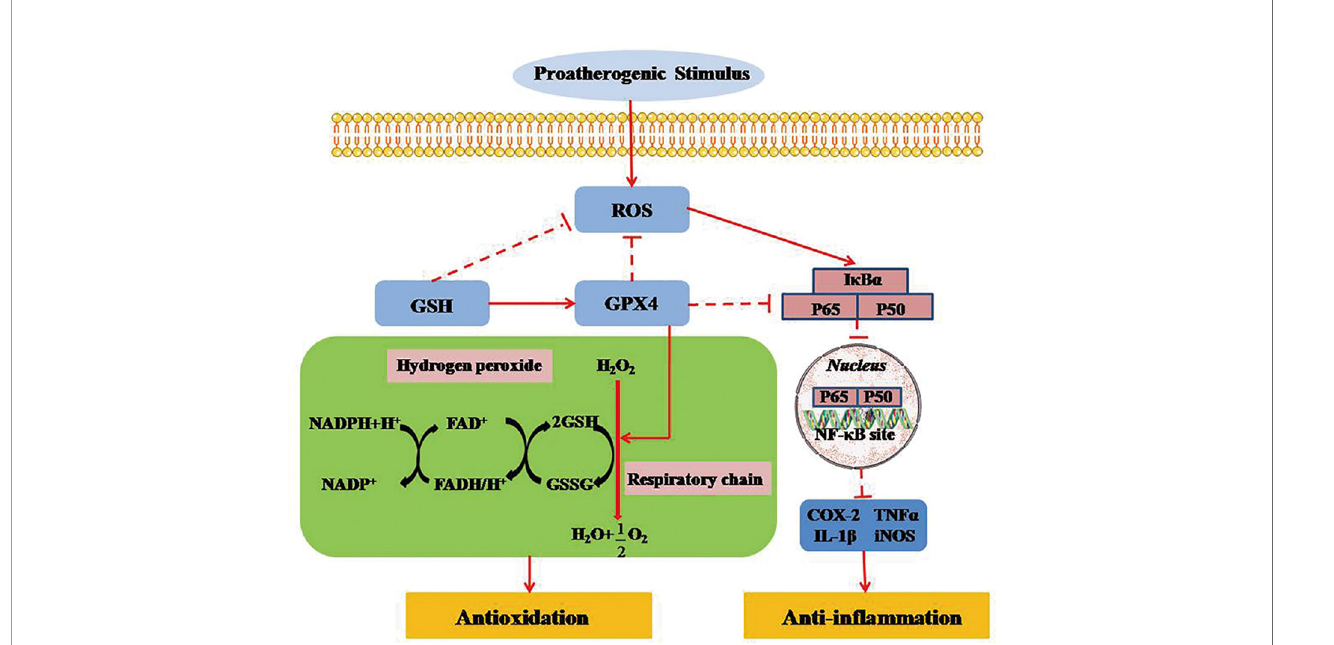
FIGURE 5 | GPX4 regulates necroin fl ammation by inhibiting TNF- a -mediated NF- k B signaling. TNF- a regulates cell survival and death by activating the key transcription factor of NF- k B. NF- k B signal activation, as a downstream promoter element of TNF- a , is negatively suppressed in intracellular survival signaling. Inversely, TNF- a -mediated NF- k B signaling can be markedly activated when ROS is produced in mitochondria. GPX4 can attenuate the necroin fl ammatory response and suppress the in fl ammatory cytokines by down-regulating TNF- a -mediated NF- k B signaling pathway. ROS, reactive oxygen species; GPX4, glutathione peroxidase 4; GSH, glutathione; GSSG, glutathione disul fi de; FAD/FADH, fl avin adenine dinucletide; NADP/NADPH, nicotinamide adenine dinucleotide phosphate; NF-KB, nuclear factor k B; I k B a , inhibitor of NF- k B a ; TNF- a , tumor necrosis factor- a ; LT, leukotriene; COX, cyclooxygenase; NOS, nitric oxide